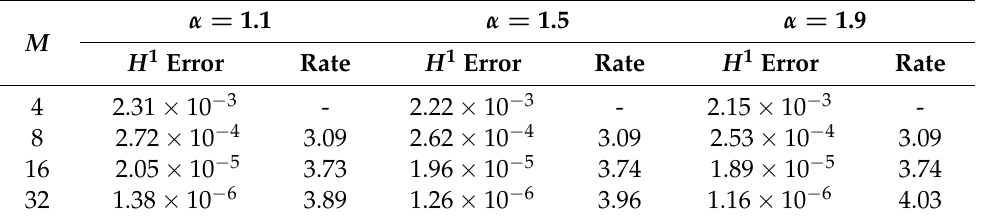
Table 2. The H 1 -norm errors in space for the smooth case in Example 1 with τ = 1/4000.